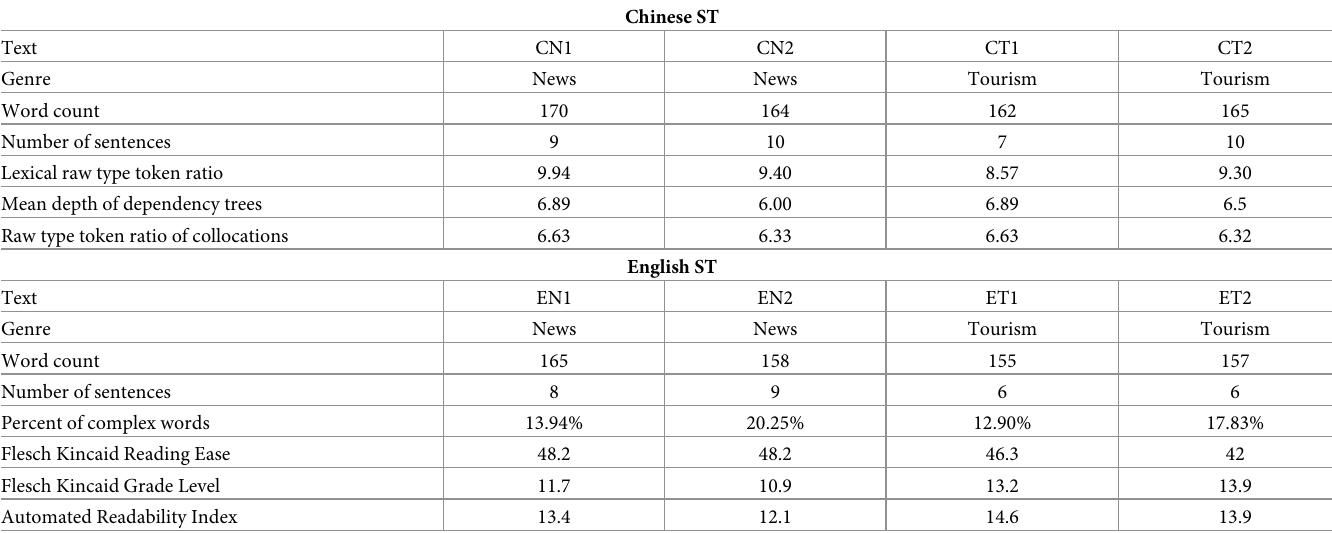
Table 1. Summary of the textual information of English and Chinese